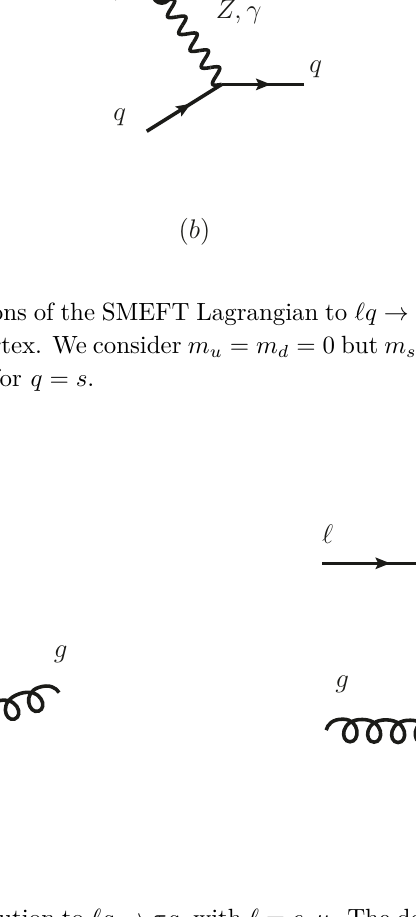
Figure 4 . Higgs and Z contribution to ‘g → τg , with ‘ = e, µ . The dot indicates the CLFV vertex. Q is a heavy quark, namely Q = c, b, t , and q = u, d, c, s, t, b